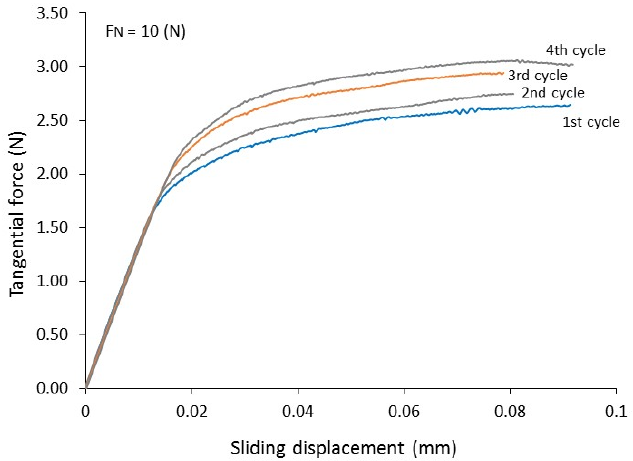
Figure 16. Tangential force–displacement plots at the contacts of LBS grains indicating the effect of the shearing cycle at a normal force of 10 N.